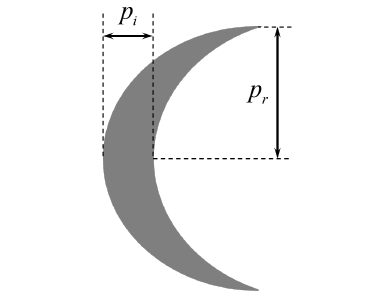
) and illumination parameter ( p r